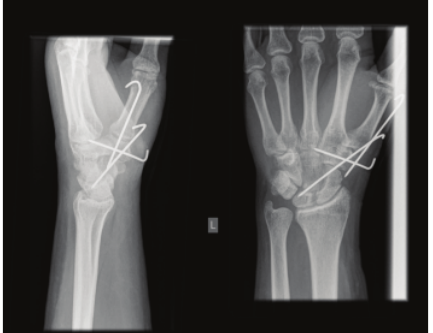
Figure 1: Preoperative radiographs.